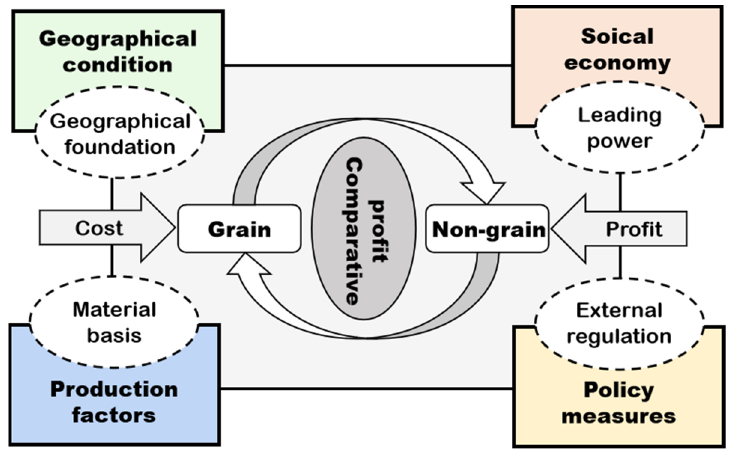
Figure 1. The analysis framework of NGPCL.